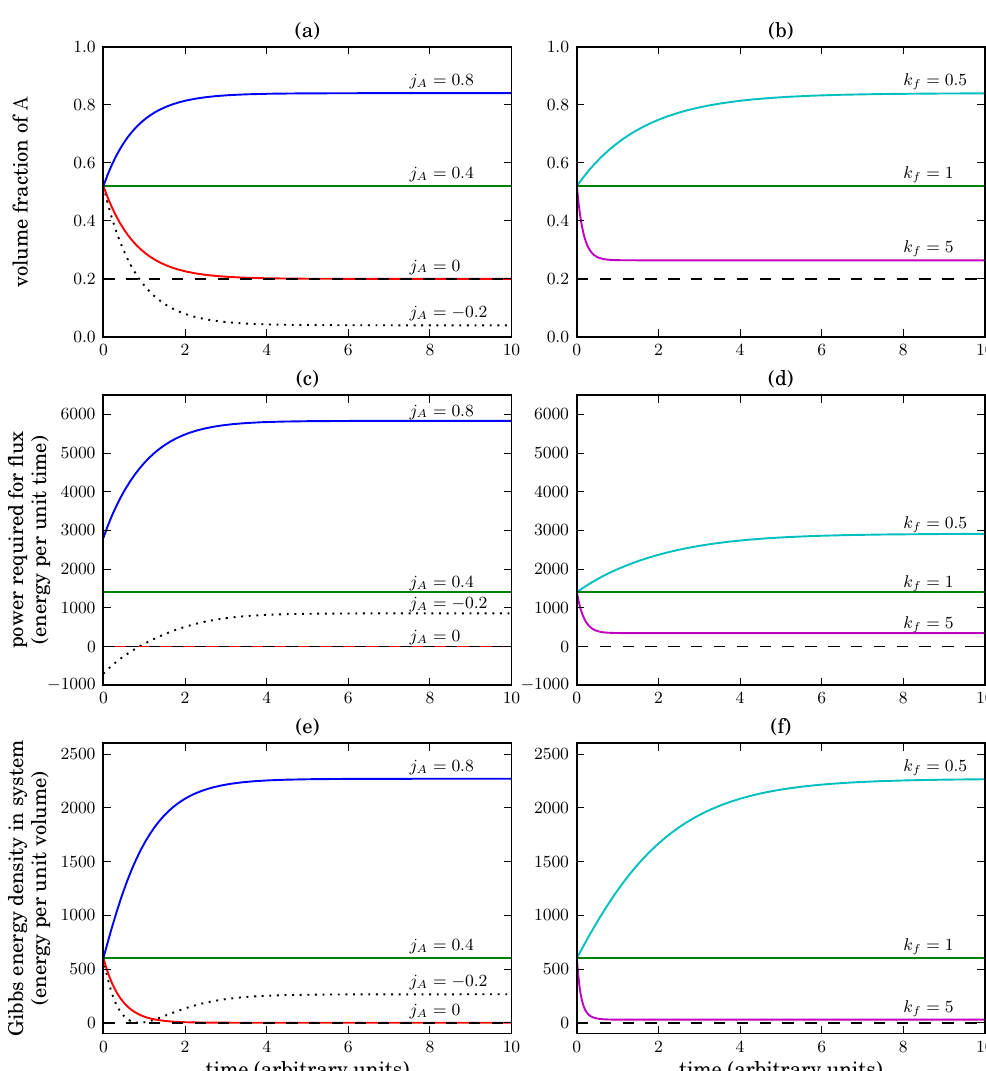
Fig. 3. Evaluation of the role of exchange fluxes and chemical kinetics in shaping chemical disequilibrium in the simple system explored in Sect. 3. (a) shows some example solutions to Equation 8, showing the volume fraction of A over time. In this plot we fix the parameters k f =1 and k r =0.25, and vary the rate j A of the driving process. V and c are set to 1. The initial value of [A]=0.52 is such that a flux of 0 . 4 will maintain this value as a steady state. Fluxes higher or lower than this result in the system converging to a different steady state. If the flux is zero the system converges to the chemical equilibrium state (dashed line), whereas the greater the rate of the driving process, the further away the final steady state is from thermodynamic equilibrium. The dotted line shows what happens if the flux has the opposite sign (B added and A removed): the system converges to a steady state that is away from equilibrium in the opposite direction. (b) is similar, except that we hold j A constant at 0.4, and vary both k f and k r so as to keep K eq = k f /k r equal to 4 (i.e. the thermodynamic properties are kept constant but the overall speed of the kinetics is changed). The steady-state concentration of A depends on both the flux and the kinetics; systems with fast kinetics ( k f =5) converge to a state closer to equilibrium than those with slow kinetics ( k f =0.5), as well as approaching their steady-state value more rapidly. (c) and (d) show the same trajectories as (a) and (b) , except that we plot the power required to drive the flux j A , according to Eq. (12). Note that in plot (c), the flux with the negative sign initially has a negative power. This is because A is initially in excess, and hence work could in principle be extracted by converting it to B. However, once the system reaches a steady state, A is no longer in excess and the power required is positive. In (d) one can see that when the kinetics of the dissipating reaction are fast, less power is required to maintain the flux. This is because the steady states of these systems are closer to equilibrium. Finally, (e) and (f) show the total amount of Gibbs energy, G , resident in the system, according to Eq. (16). This can be considered a measure of disequilibrium. When the flux is 0 in (e) , the Gibbs energy approaches its minimum value of zero, indicating that the system is in equilibrium. Fluxes with a higher magnitude generally push the system toward higher Gibbs energies. The dotted line reaches the minimum and then increases again because the concentration of A passes through its equilibrium value. In (f) we can see that the system with fast kinetics rapidly moves very close to the minimum G value, whereas those with slow kinetics move further